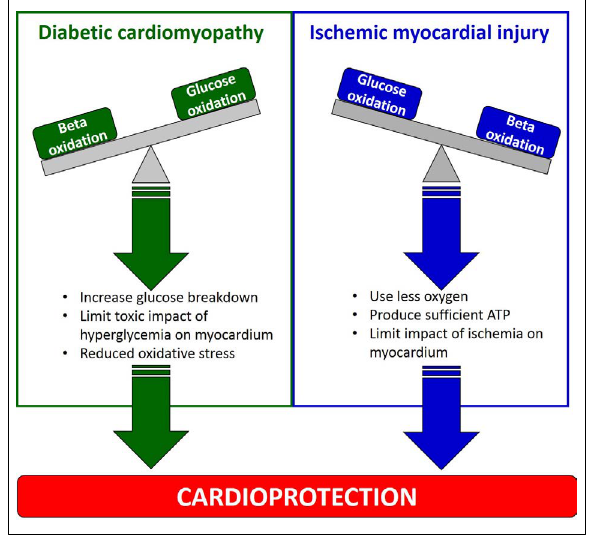
This figure demonstrates the role of glucose- and beta-oxidation in mitigating diabetic cardiomyopathy and myocardial ischaemic injury. In diabetic cardiomyopathy, hyperglycaemia induces toxic effects on the myocardium (heart muscle) and, therefore, increased uptake and breakdown of glucose alleviates the impact of hyperglycaemia. During myocardial ischaemia, increased myocardial glucose oxidation is a better fuel option, as it produces sufficient ATP with an oxygen sparing effect. Shifting of myocardial energy metabolism toward glucose oxidation, irrespective of whether diabetic cardiomyopathy or ischaemia- reperfusion is present, promotes